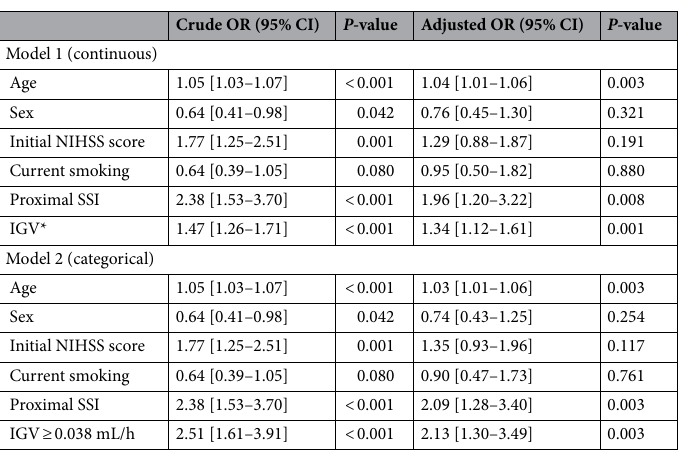
Table 3. Multivariable logistic regression analysis of possible predictors of early neurological deterioration. NIHSS National Institutes of Health Stroke Scale, SSI single subcortical infarction, IGV infarct growth velocity. *These variables were transformed into a log